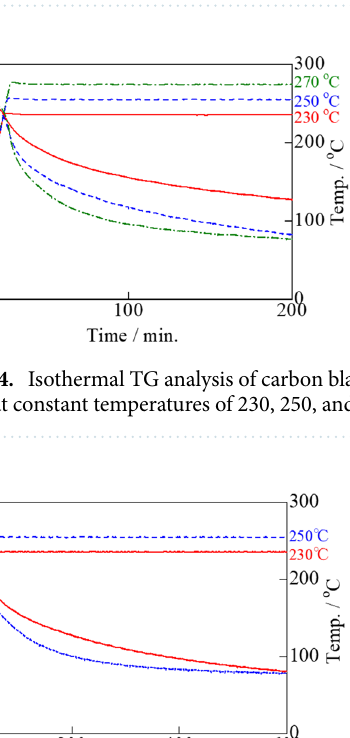
Figure 13. DSC curves of carbon black (2 wt%) mixed with the various Tl 2 O 3 ‒ x wt%Bi 2 O 3 ( x = 95–99.9) composite catalysts.